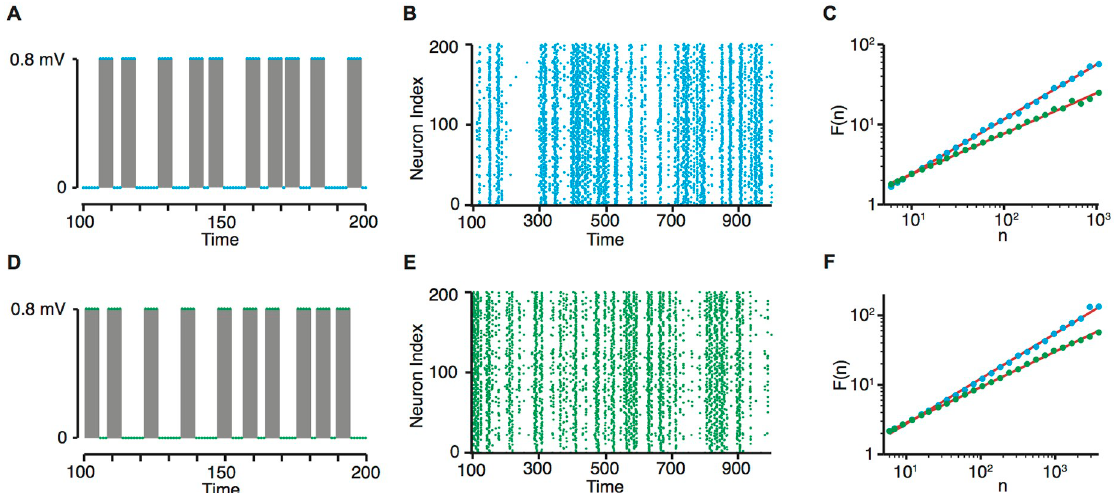
Fig 1. Network input and burst dynamics. (A,D) Networks were driven by a bursty input. Bursts of activity (grey shaded region) were of fixed duration and amplitude, and interspersed within periods of silence—inter-burst intervals (IBIs). (A) Example burst dynamics for the first few bursts within a simulation where IBIs exhibited LRTC, and (D) the same IBIs randomly shuffled. (B,E) Raster plot of network firing at the start of a simulation, demonstrating that burst dynamics also occur within the network. Firing dynamics are shown for the network driven with LRTCs (B, blue), and driven with the same IBIs randomly shuffled (E, green). (C) DFA plots of the IBI sequences for the network external input across simulations of length 100, 000. The Hurst exponent is estimated by the slope of the line of best fit, which in these examples were H = 0.68 (with LRTC input, blue), and H = 0.51 (with the same input shuffled in time, green). (F) DFA plots for the burst dynamics of the network firing across the same simulations. For these examples the Hurst exponents of the network firing were estimated as H = 0.65 when the network was driven by an external input which exhibited LRTCs (blue), and H = 0.51 when the network was driven with the same input randomly re-ordered in time (green). n is the box size and F ( n ) is the root mean square of the detrended signal across the box (see Estimation of the Hurst exponent in the